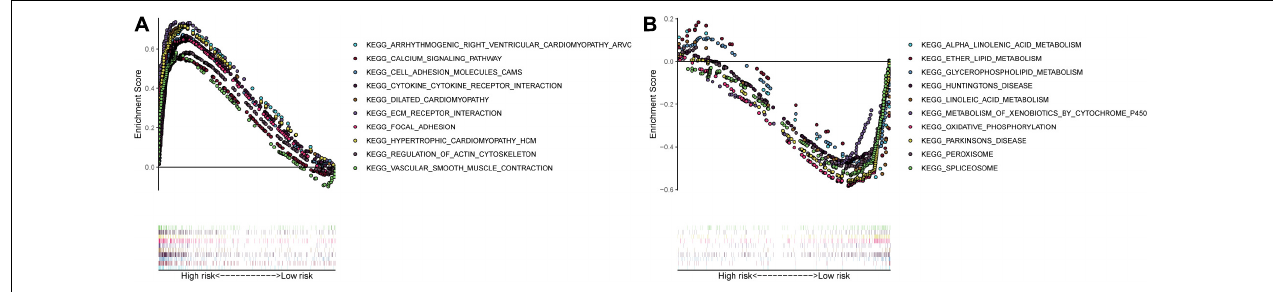
FIGURE 12 | Multiple GSEA pathways in the high- and low-risk groups. The top 10 KEGG signaling pathways in the (A) high-risk and (B) low-risk